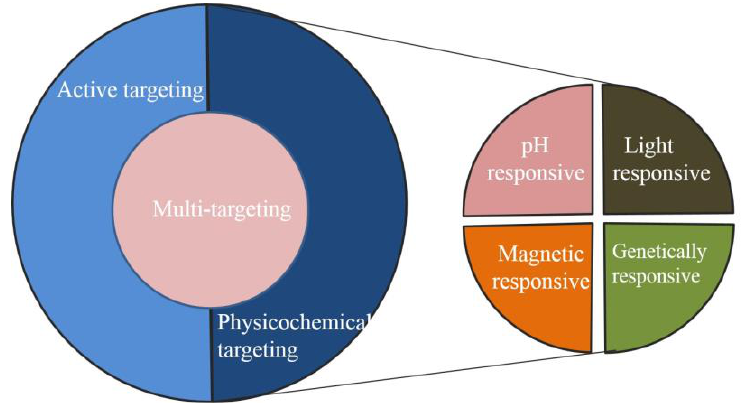
Figure 2. Schematic diagram of the types of tumor-targeted treatment strategies based on MOFs. Table 3. Targeting strategies for metal organic frameworks.